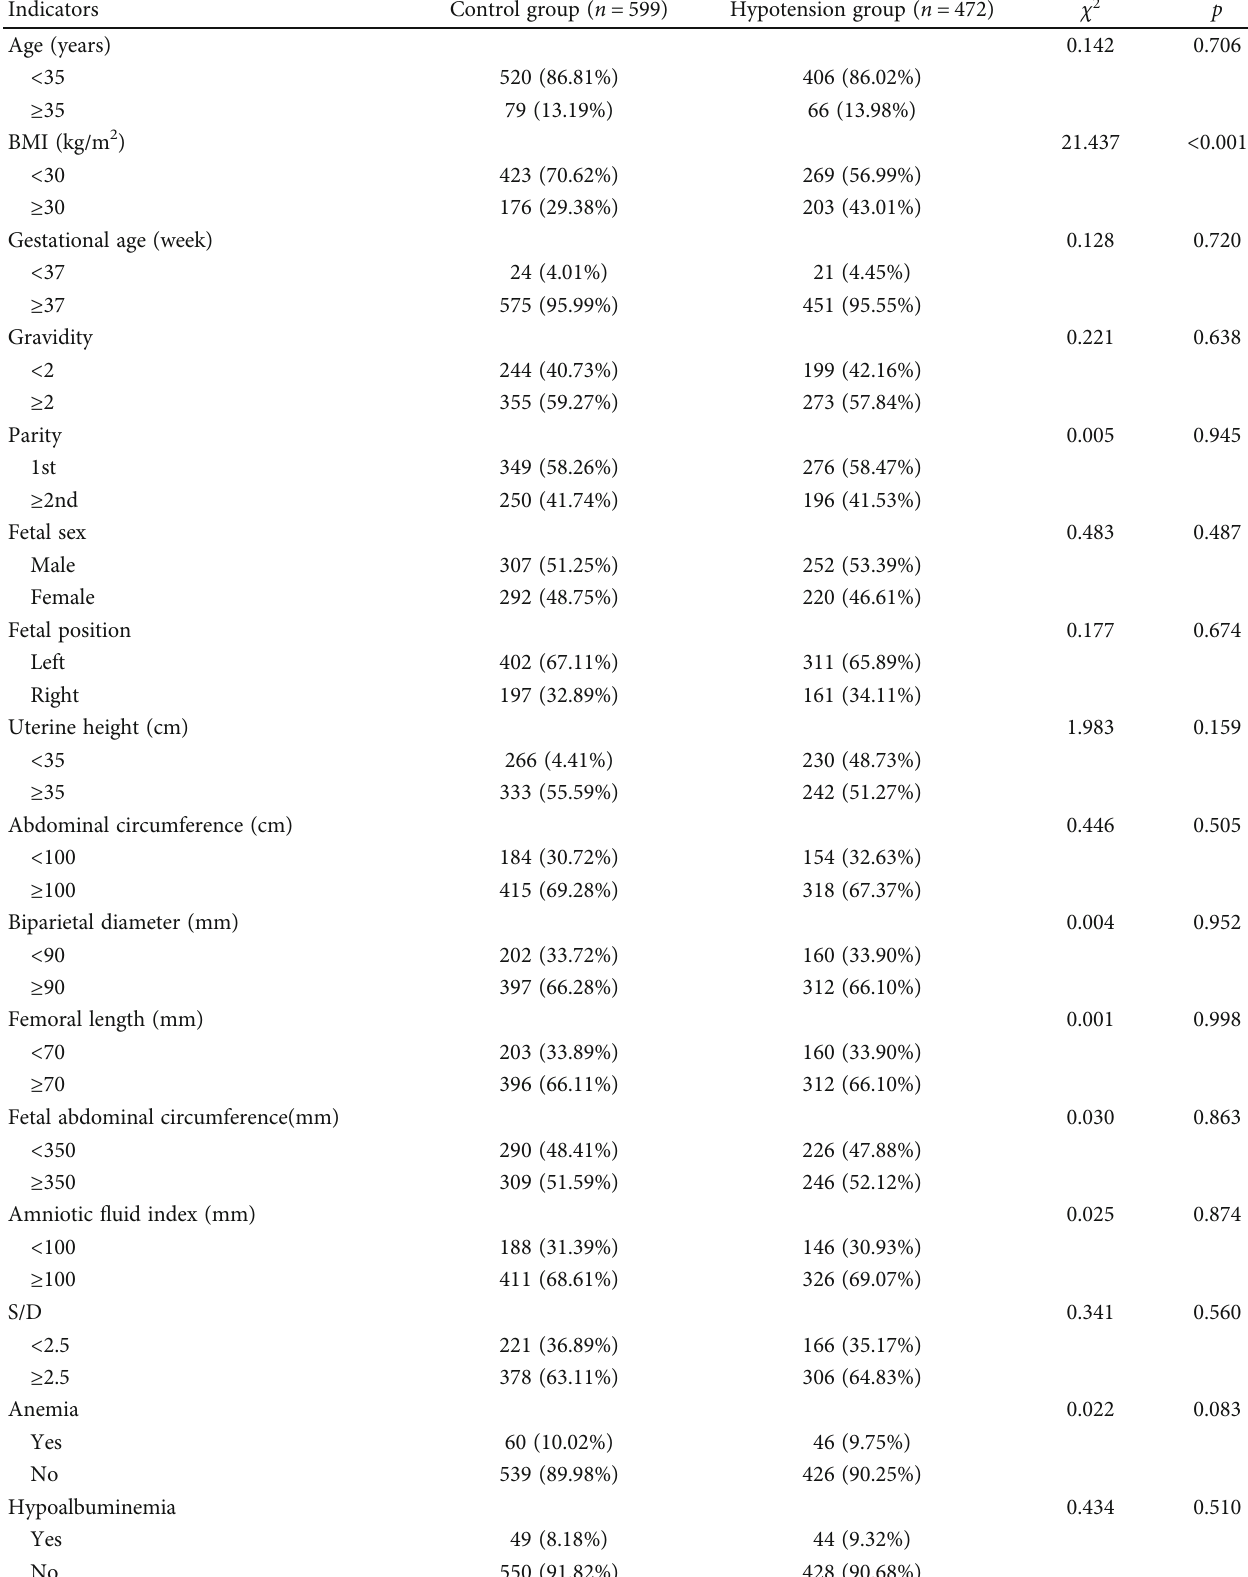
Table 2: Univariate logistic regression analysis of risk factors for intraoperative hypotension in cesarean section